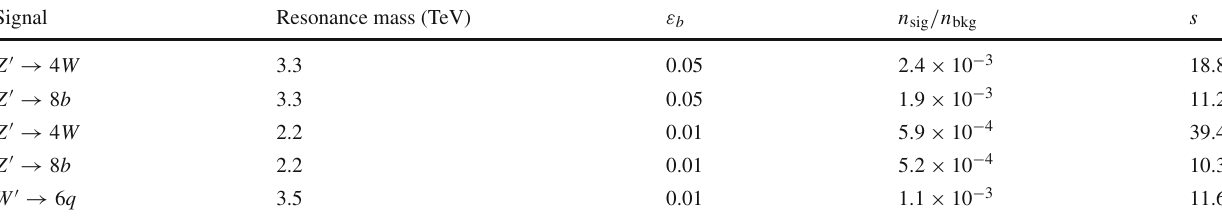
Table 2 Significance improvement s in some of the examples analysed in Sects. 5 and